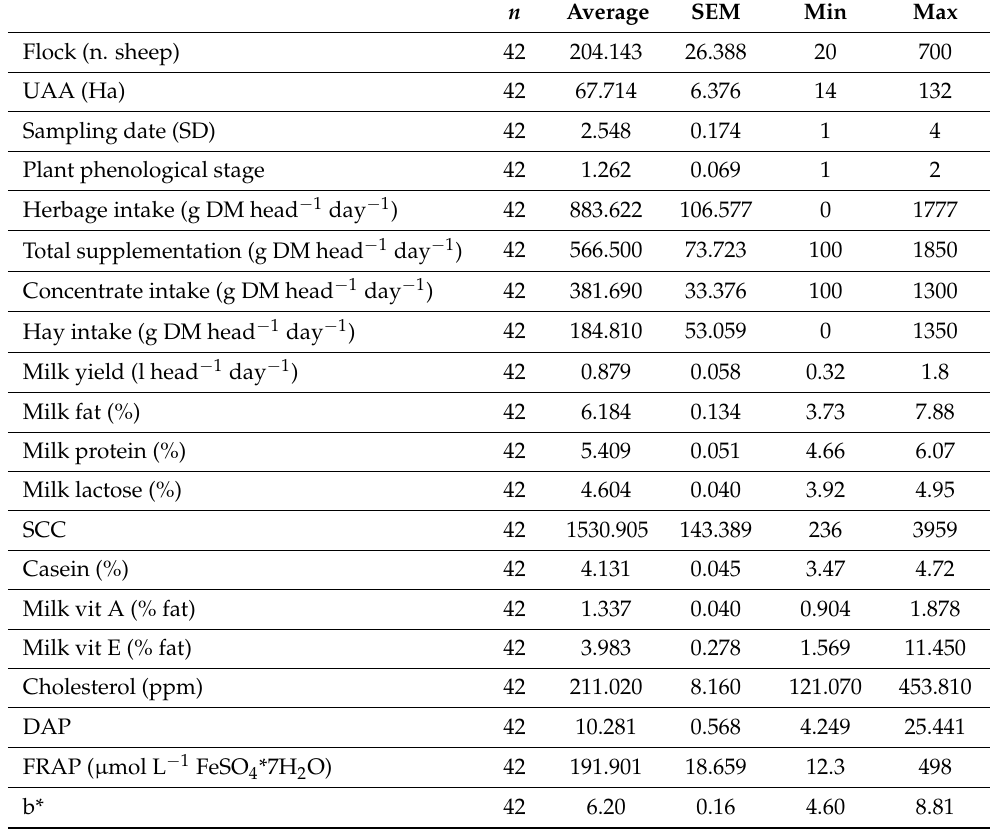
Table 1. Descriptive statistics for farm structure, husbandry, managerial factors, and milk traits. n Average SEM Min Max Flock (n.